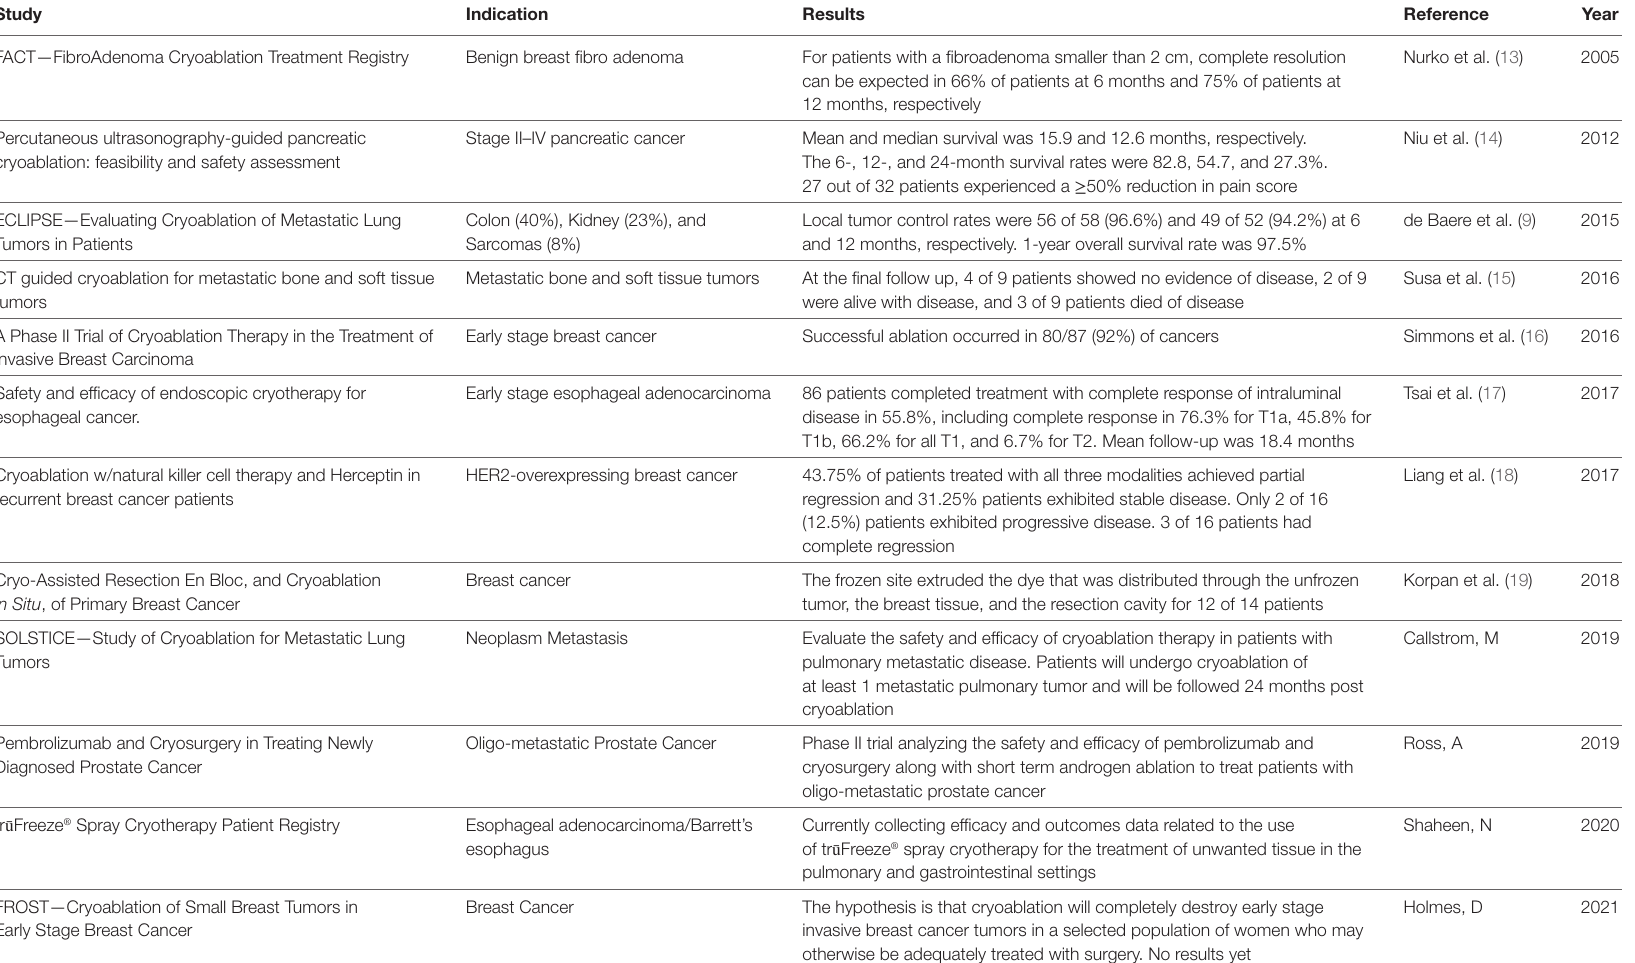
TABLe 1 | Pioneering cryotherapy studies in the oncology